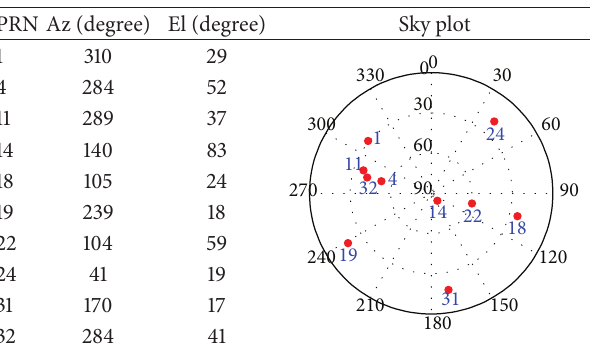
Table 13: Satellite visibility during test: real